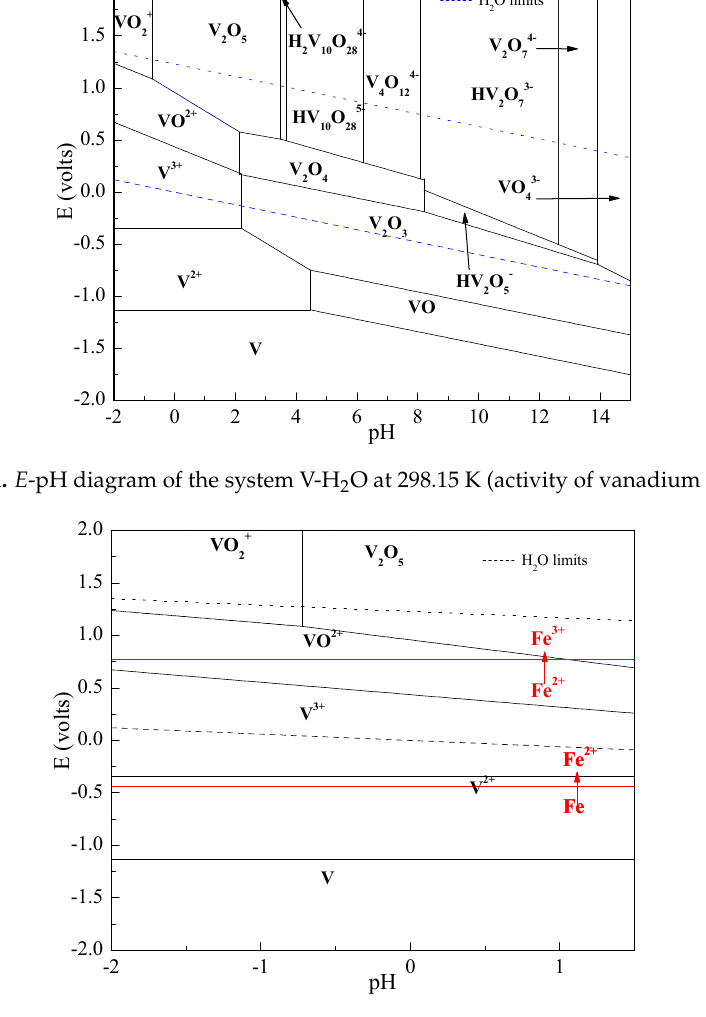
Figure 2. E -pH diagram of the V-H 2 O and Fe-H 2 O systems at 298.15 K and low pH (Activities: Vanadium 1.0, iron 1.0).